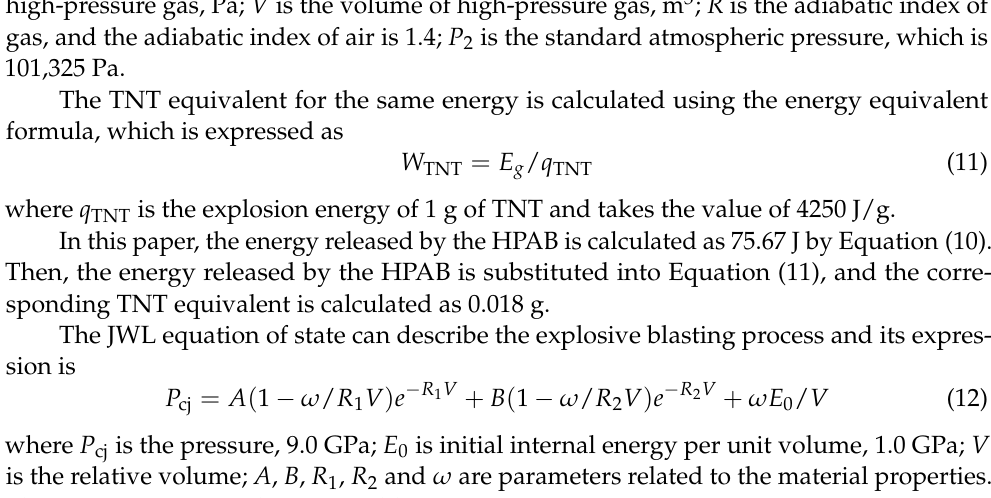
Table 2. The parameters of the JWL equation of state for